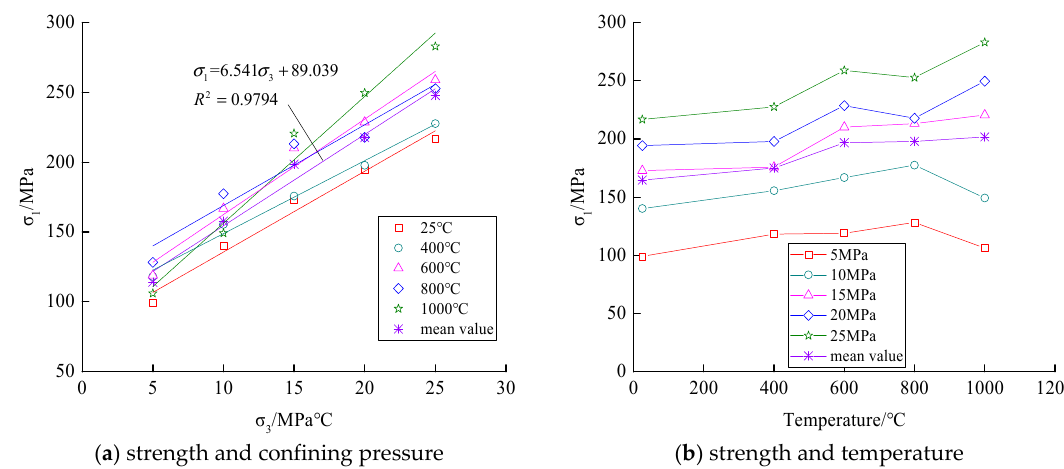
Figure 14. Relationship between three axis strength and confining pressure and temperature after high temperature. Table 1. Strength characters of samples under conventional triaxial compression after temperature.